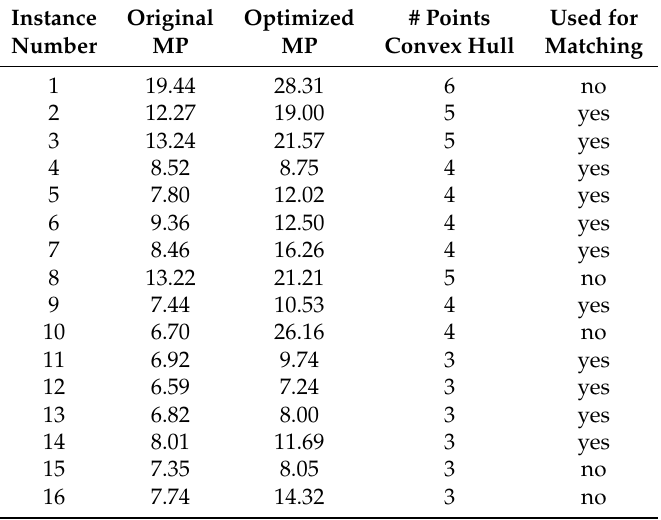
Table 1. MP values obtained by optimizing “by hand” each instance of C 6